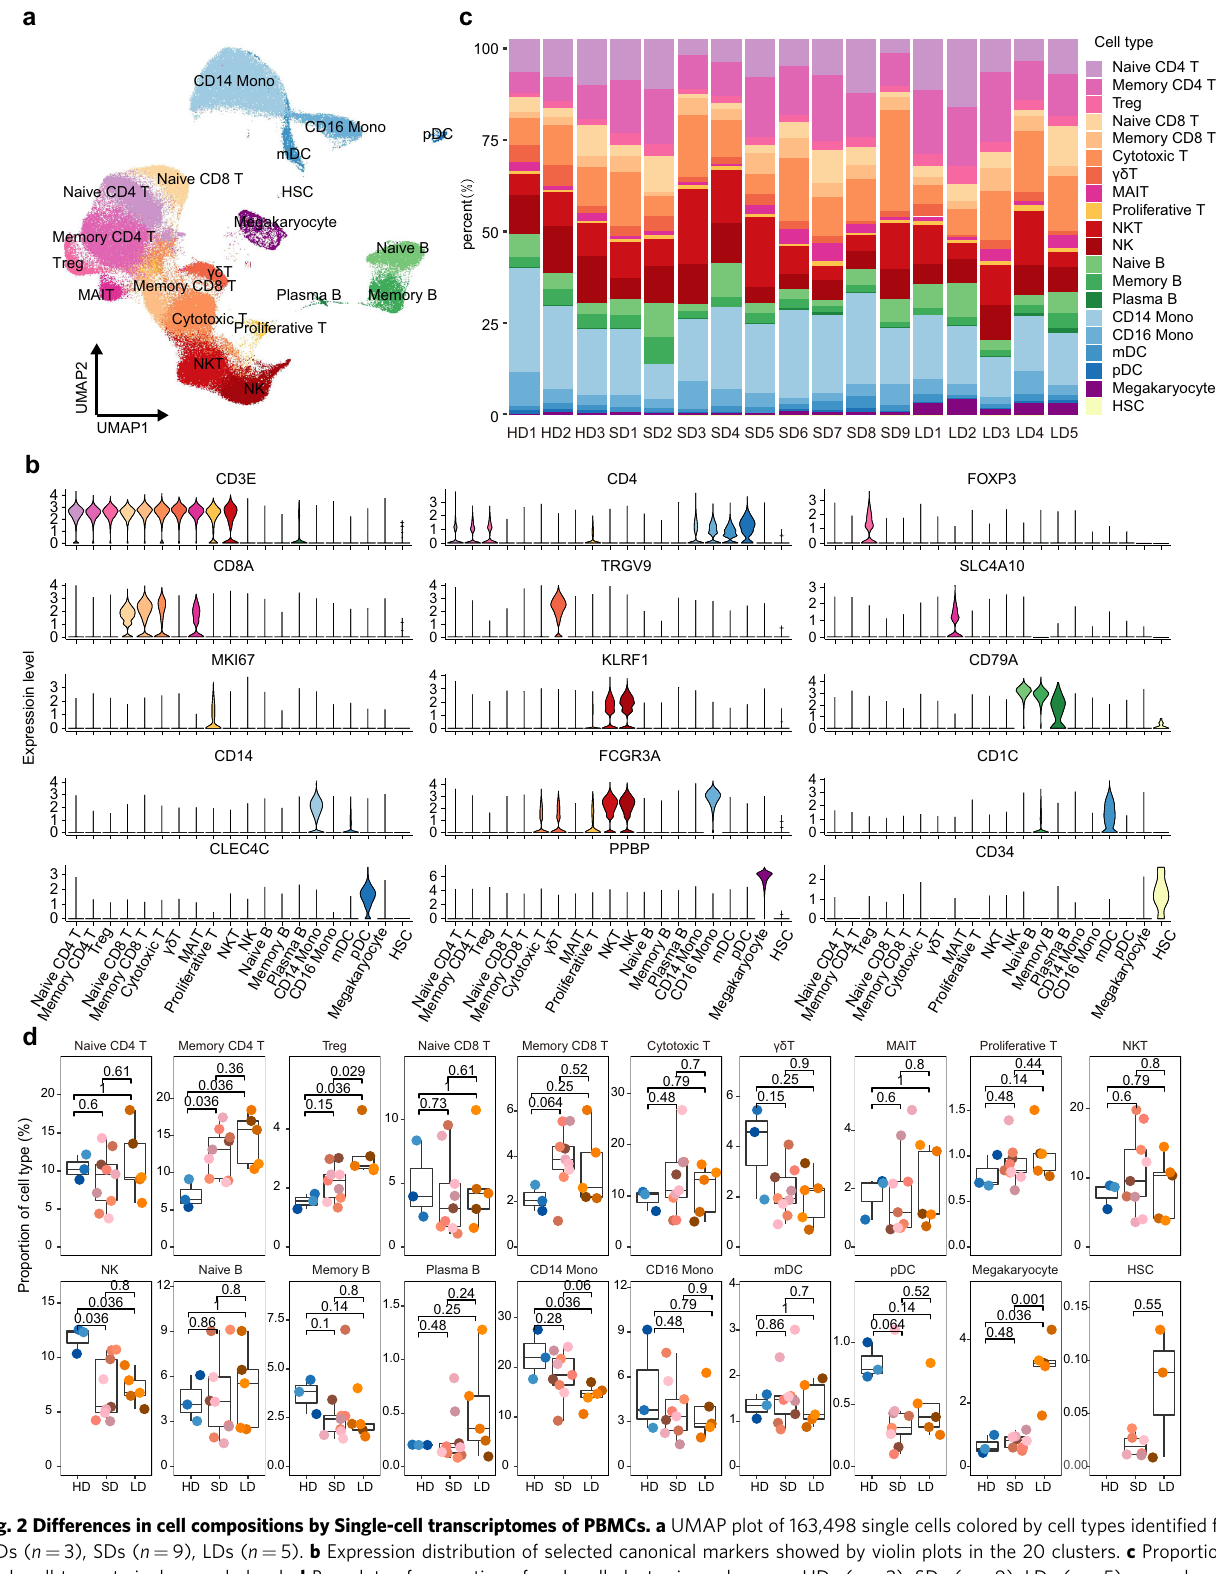
Fig. 2 Differences in cell compositions by Single-cell transcriptomes of PBMCs. a UMAP plot of 163,498 single cells colored by cell types identi fi ed from HDs ( n = 3), SDs ( n = 9), LDs ( n = 5). b Expression distribution of selected canonical markers showed by violin plots in the 20 clusters. c Proportion of each cell type at single sample level. d Box plots of proportion of each cell cluster in each group. HDs ( n = 3), SDs ( n = 9), LDs ( n = 5) were shown in different colors. Horizontal lines represent median values, with a maximum of 1.5 × interquartile range. One-sided Wilcoxon rank-sum tests were conducted between each group. Source data are provided as a Source Data fi